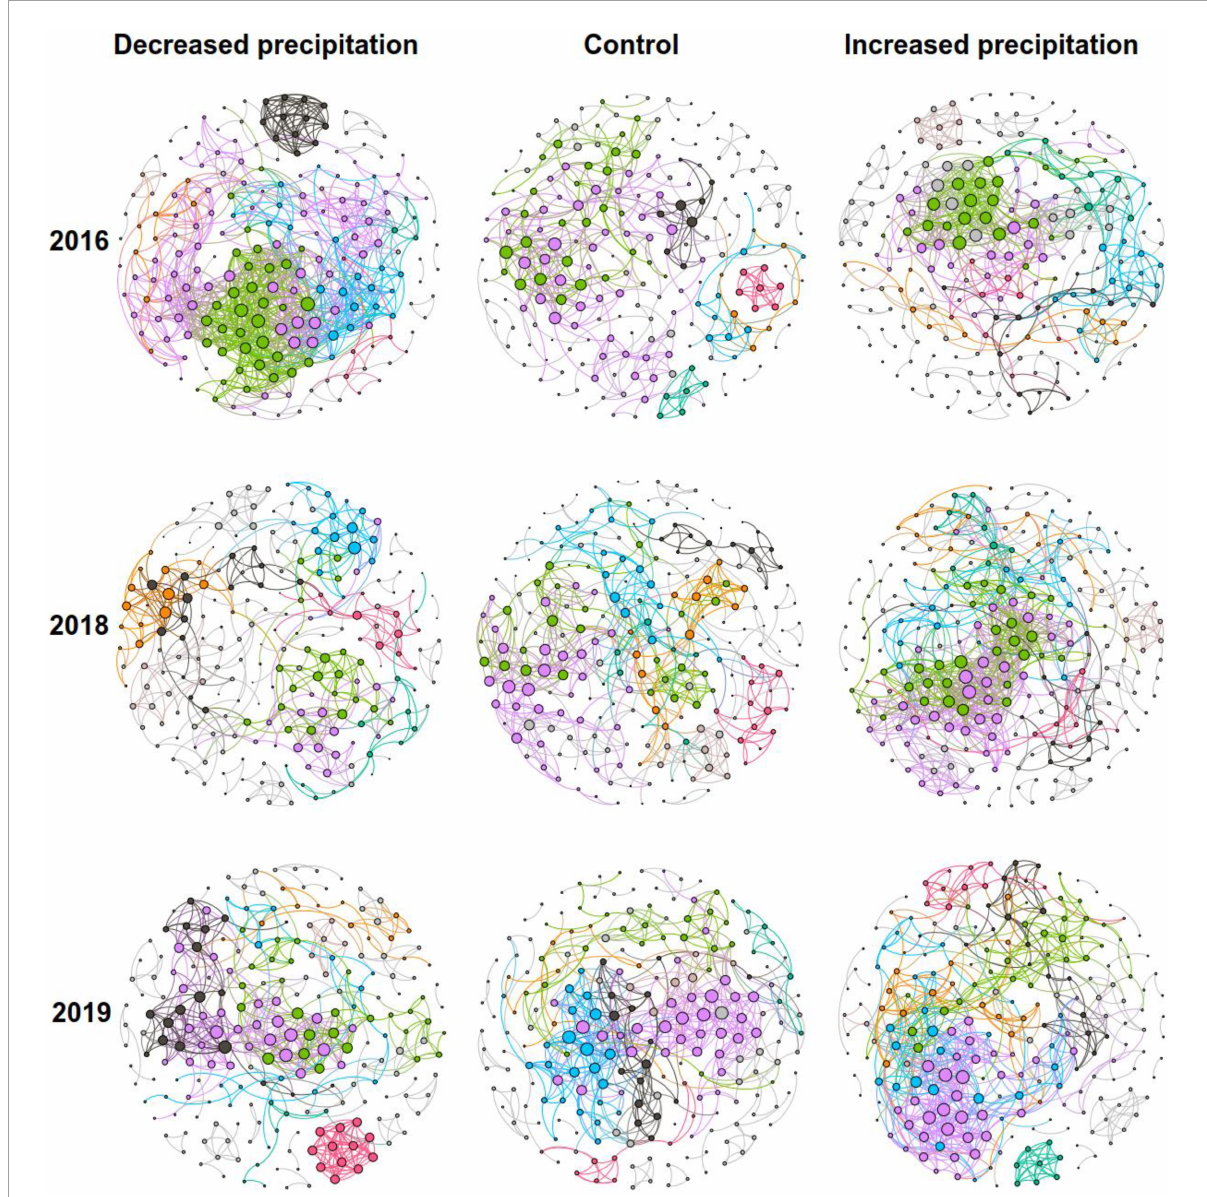
FIGURE1 Co-occurrence network patterns of communities of constructed bacteria in different precipitation gradients. The six largest modules are represented by different colors, and the other modules are represented in